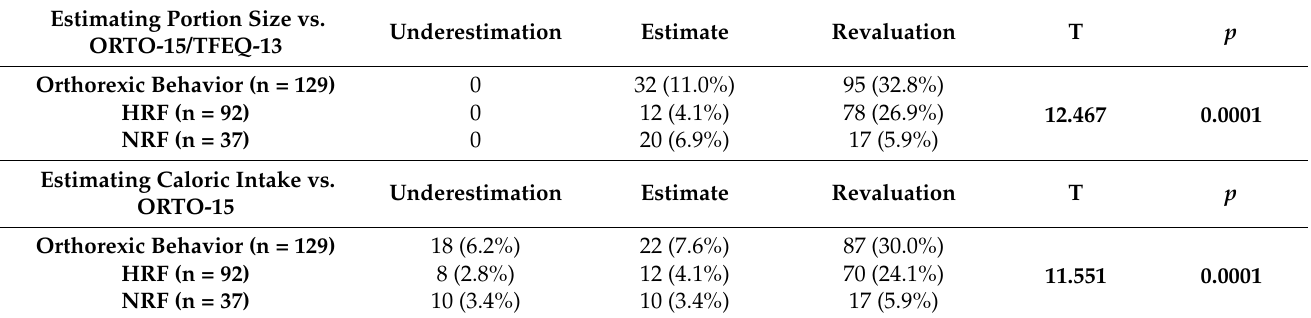
Table 5. Relationship between demonstrated ability to estimate portion size and group at increased risk for orthorexia (n =